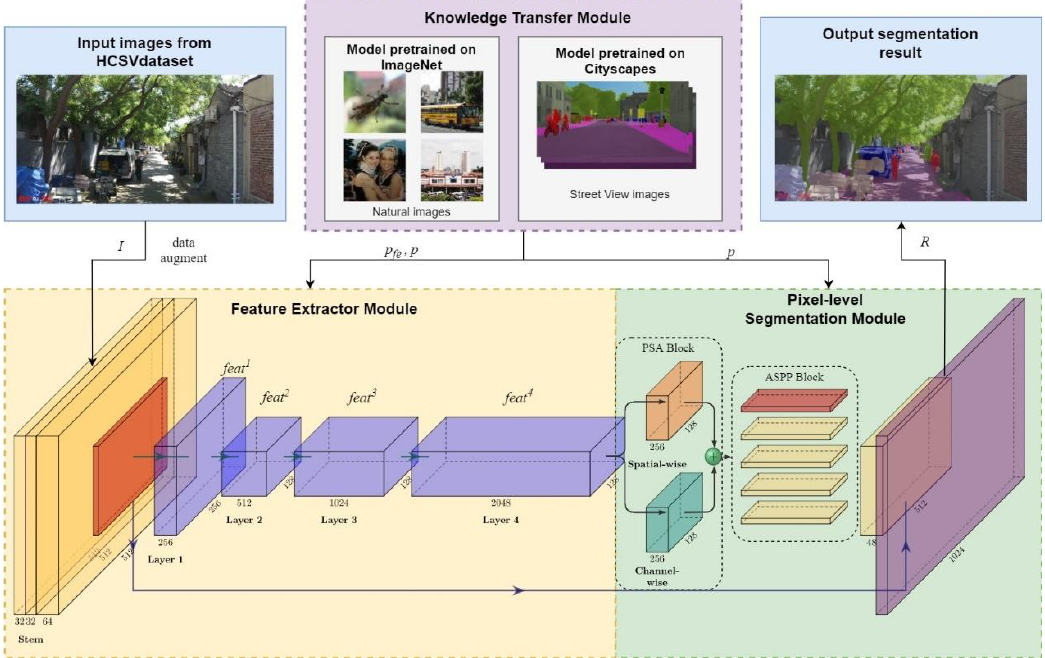
Figure 4. Flowchart of the proposed PALESNet. A feature extractor module is used to extract features from the street view images. Features are sent to the segmentation module to recognize landscape features, where the PSA block is utilized to make the feature more discriminative and the ASPP block is used to capture the multiscale representation of each feature. The knowledge transfer module is activated during the training phase, to initialize the parameters for both the feature extractor and the segmentation network.